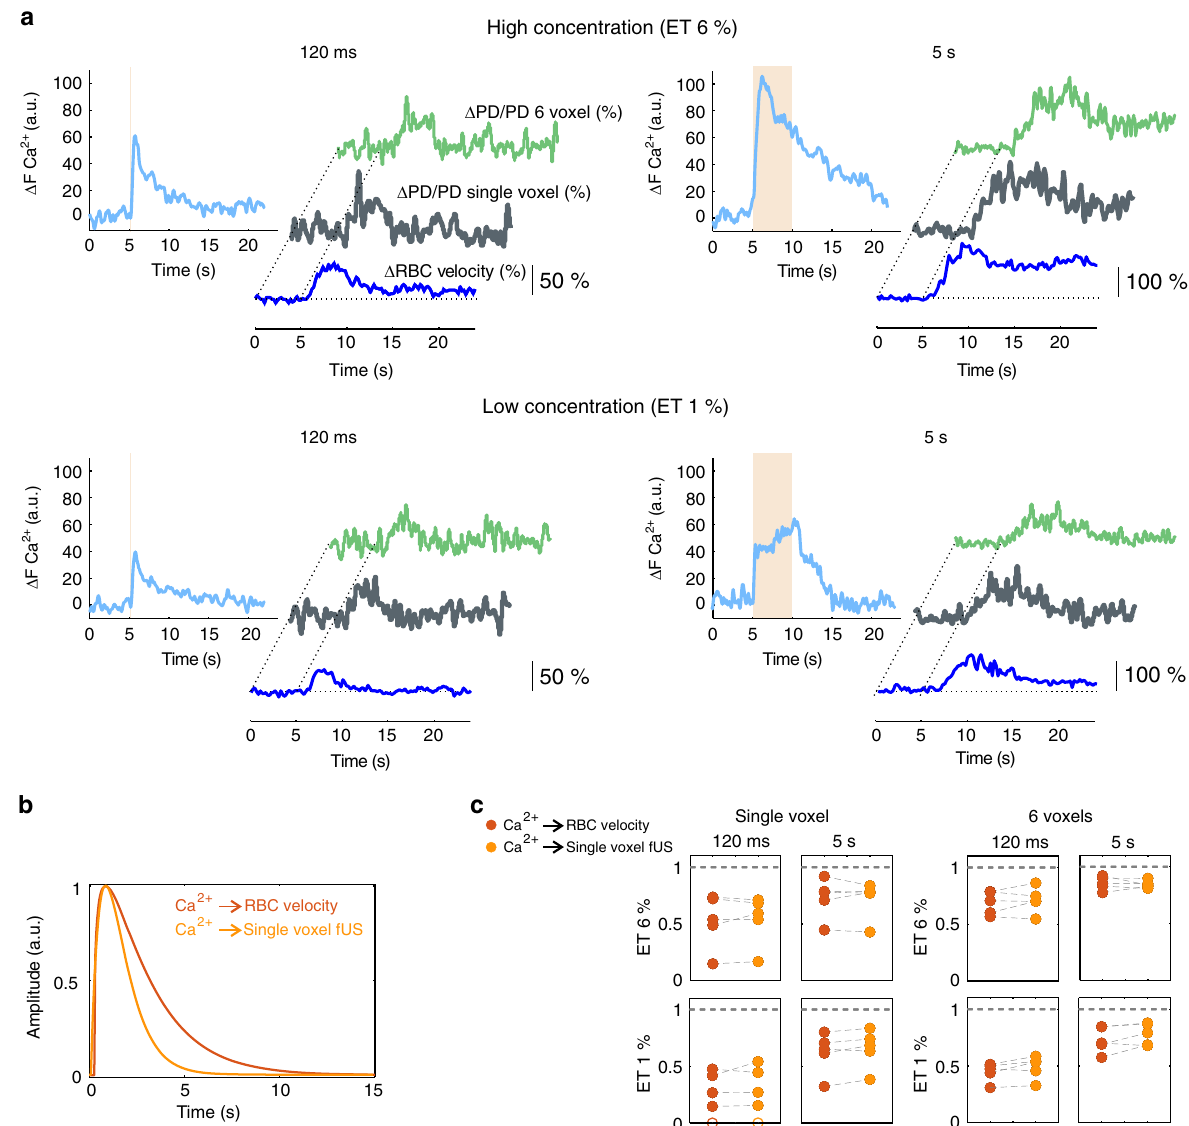
Fig. 4 Co-registration of microscopic and mesoscopic vascular responses to odor. a Microscopic responses were acquired in a glomerulus located in the center of a fUS voxel. The four panels illustrate Ca 2 + , RBC velocity, and the three types of fUS responses (from the speci fi c co-registered single voxel and the group of six voxels) to four odor stimulation protocols (120 ms and 5 s stimulations at two concentrations). All responses increased with time and odor concentration. The Δ PD/PD fUS traces from single voxels are in bold. b Comparison of the μ TF and the mesoscopic TF ( M TF) optimized between Δ Ca 2 + (ET 1%, 5 s) and the co-registered single fUS voxel signal. c Prediction quality (Pearson coef fi cients) of single and six voxels fUS responses using either the μ TF (red), the neuron-derived M TF (orange) ( n = 5 mice). Note that in one mouse (bottom left plot), the single voxel signal ∼ 0 (open circles). Source data are provided as a Source Data fi